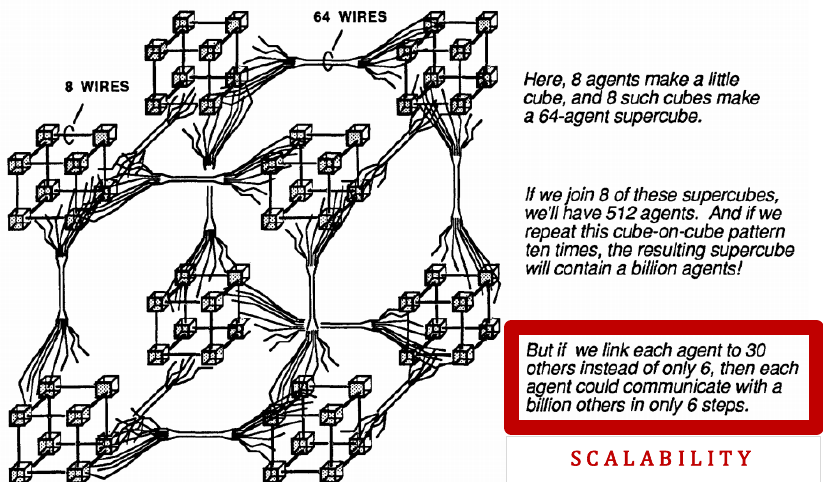
Fig. 2 - Illustration from page 315 (Appendix: Brain Connections) from Society of Mind by Marvin Minsky. MIT,